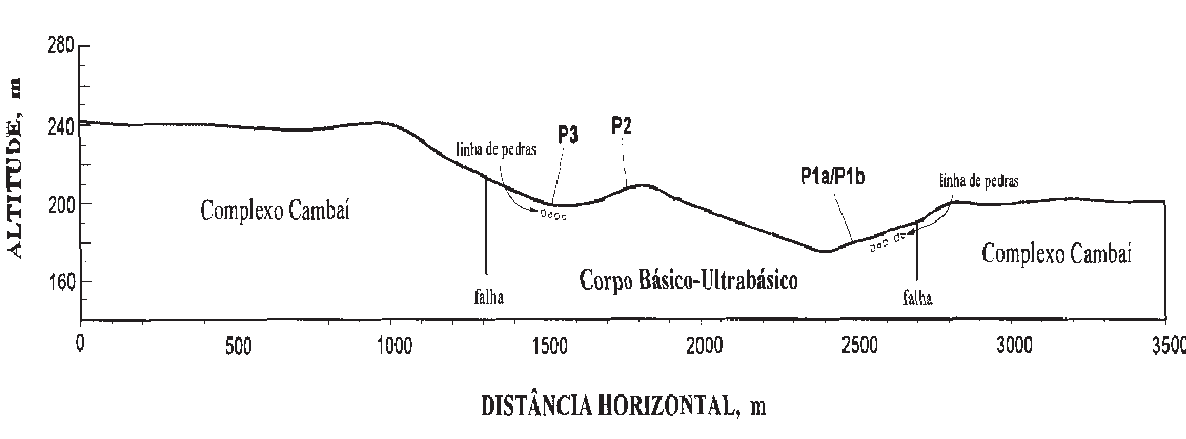
Figura 1. Posição dos perfis na paisagem e relação com as rochas graníticas do Complexo